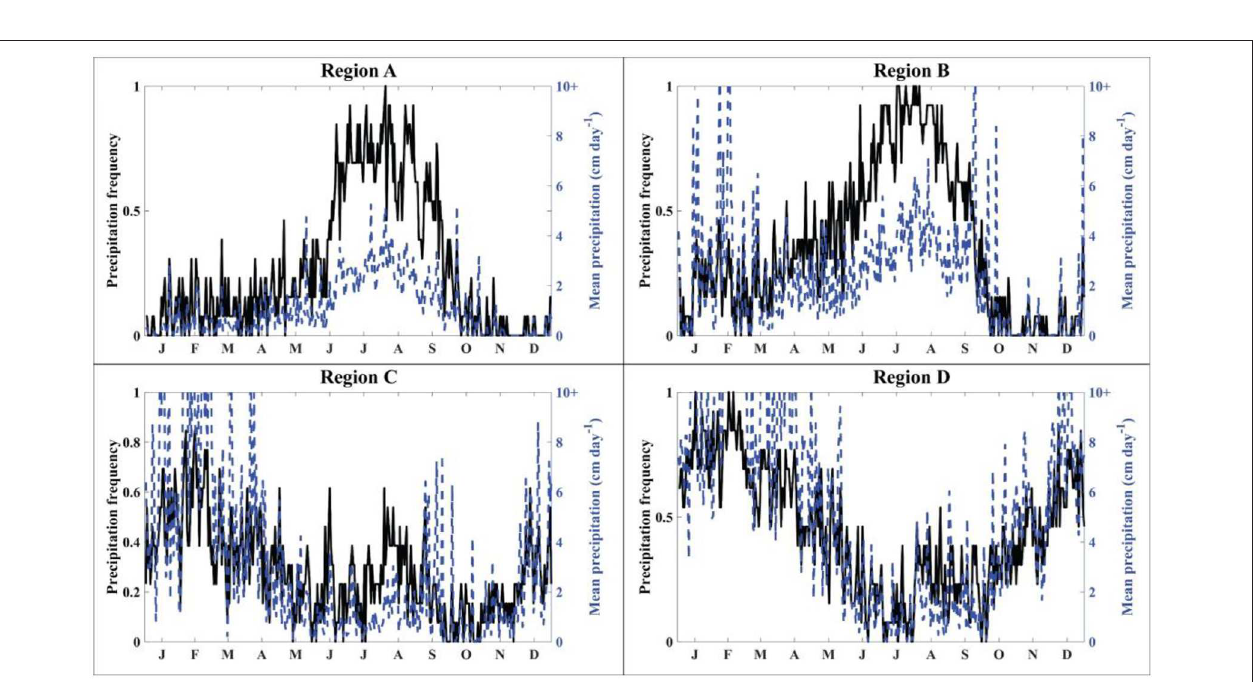
FIGURE 5 | Schematic diagram of feedbacks and trigger processes. (A) Illustrates feedbacks generally. (B–D) Illustrate the individual trigger processes tested in this study. Top panel adapted from Roe (2009).